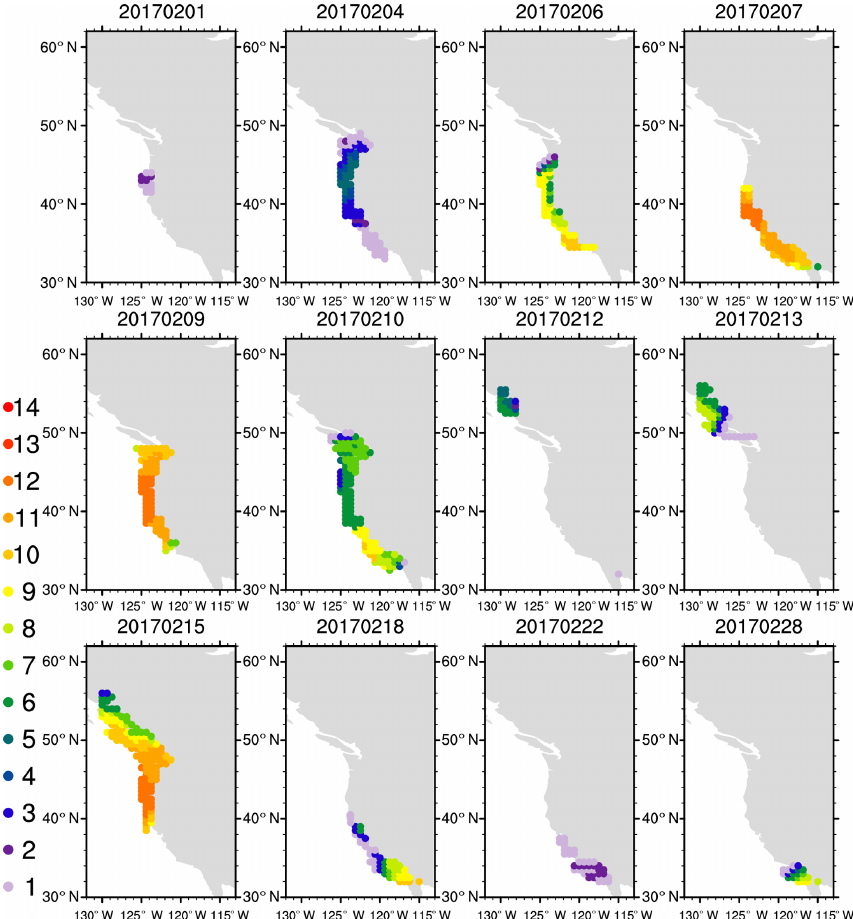
Figure 4. The number of methods that detect an AR at the coastline for sample days in February is plotted; plots are labeled with the date in YYYYMMDD format; i.e., 20170201 is 1 February 2017. Because each day had eight associated time steps, the maximum number of methods for each day is plotted. The polygons represent the number of methods; i.e., if only one method detected an AR at a specific grid point along the coast, then a light beige circle is plotted at that grid point along the coast; if 14 methods detected an AR at a specific grid point along the coast, then the darkest blue star is plotted at that grid point along the coast. Individual methods are not